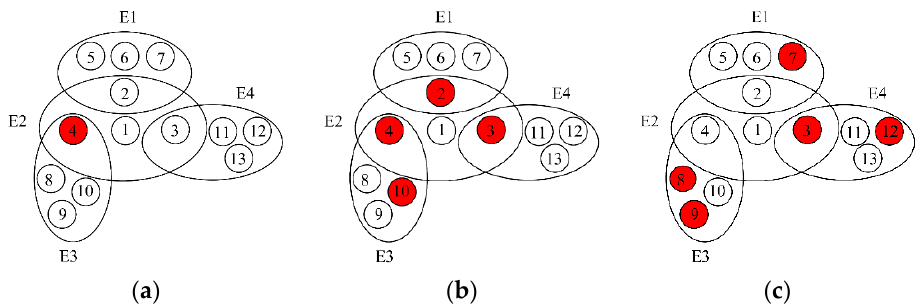
Figure 3. Schematic illustration of the spreading process on hypernetwork. ( a ) When t = 0, node 4 was set as the initial spreading seed (I-state), and the other nodes were all in S-state; ( b ) when t = 1, neighbor nodes 2, 3, and 10 of node 4 were infected and turned into I-state; ( c ) when t = 2, neighbor node 7 of node 2, neighbor node 12 of node 3, neighbor node 8 of node 4, and neighbor node 9 of node 10 were infected, at the same time, nodes 2, 4, and 10 recovered (returning to S-state).